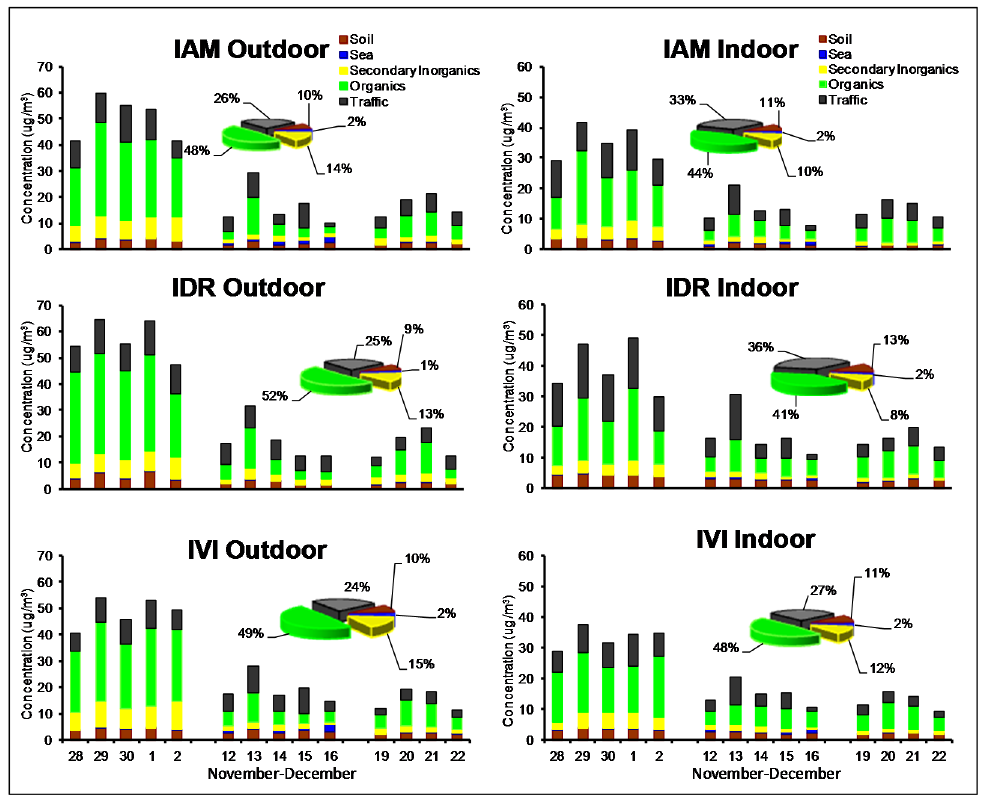
Figure 3. Outdoor and indoor daily contribution of the five macro-sources (histograms) and average composition of PM 2.5 (pie charts) during the winter